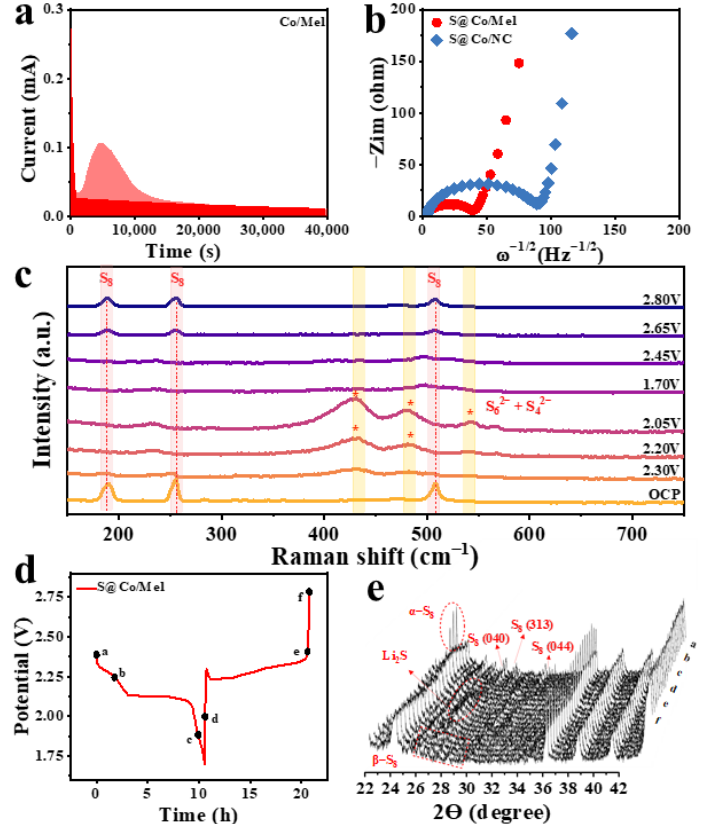
Figure 6. Potentiostatic discharge curve of the Li 2 S deposition tests using Co/Mel as substrates ( a ); EIS plot ( b ); in situ Raman spectra of S@Co/Mel ( c ); charge/discharge curve obtained during in situ XRD ( d ); in situ XRD patterns during the first cycle ( e ).